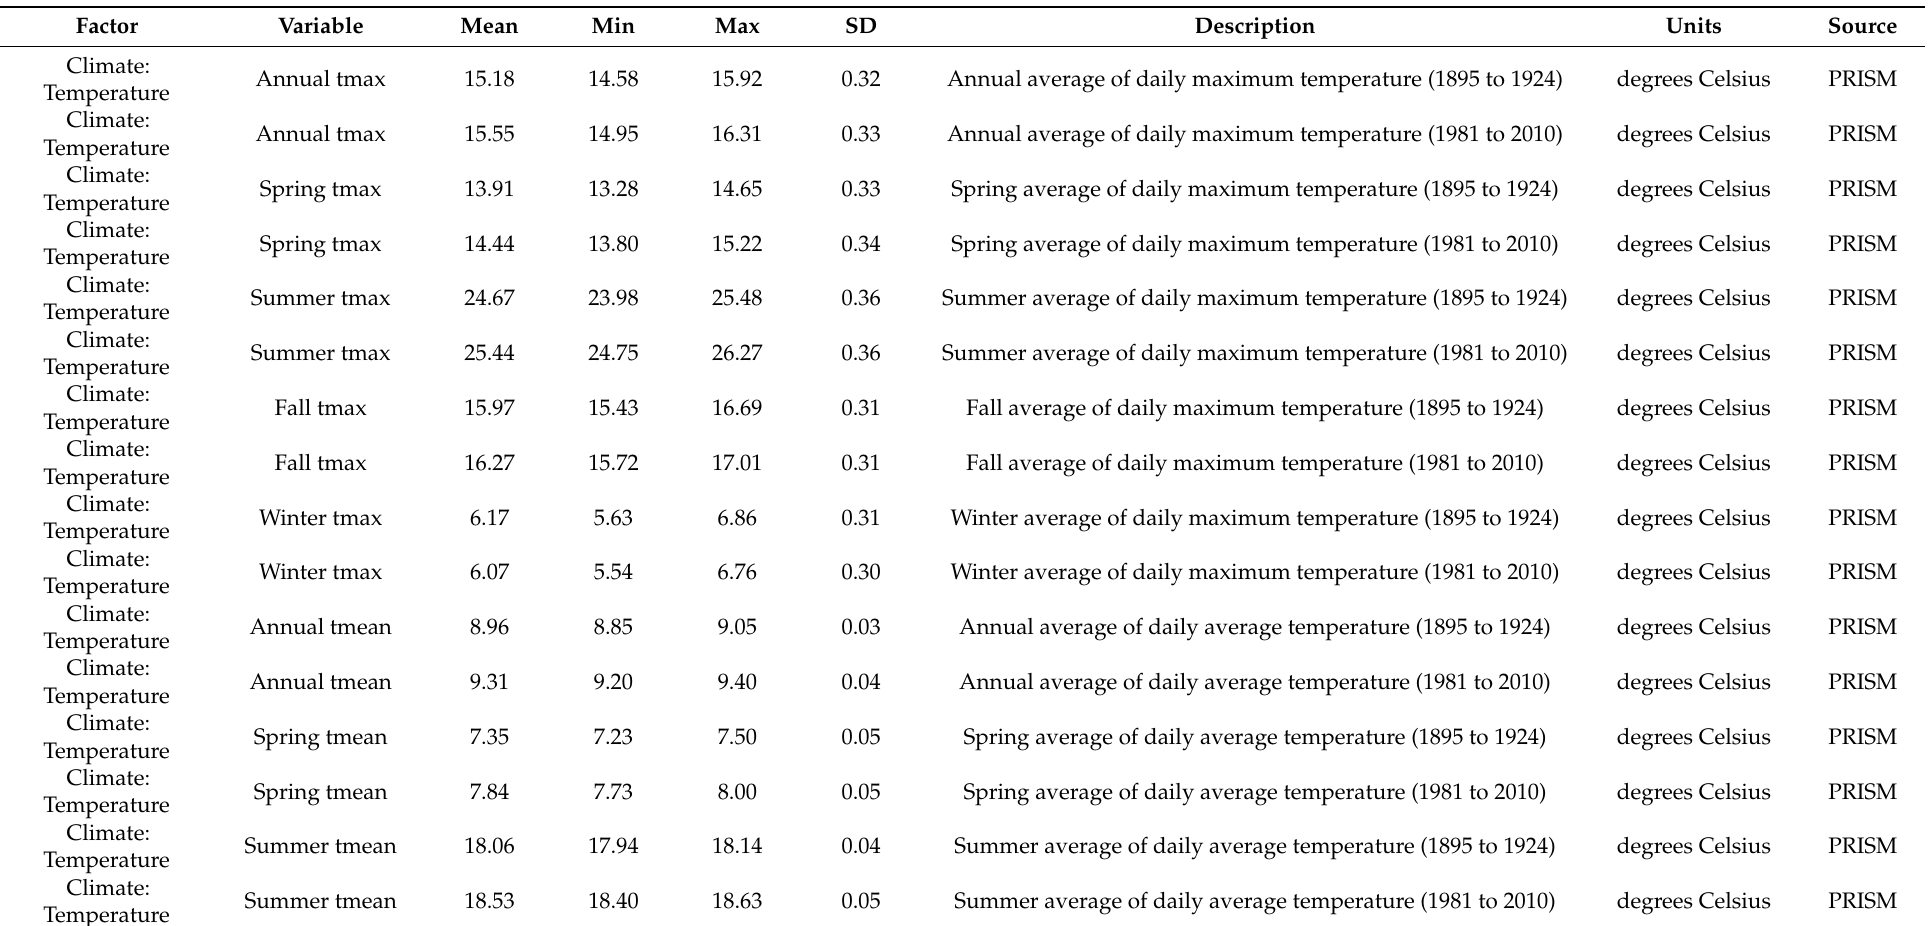
Table A1. Summary of all environmental variables considered for inclusion in models. Variables are organized by environmental factor, and subgroup if applicable. Summary statistics (mean, minimum, maximum, and standard deviation, brief description, units, and data source) are provided for each variable. Historical and contemporary climate variables are listed